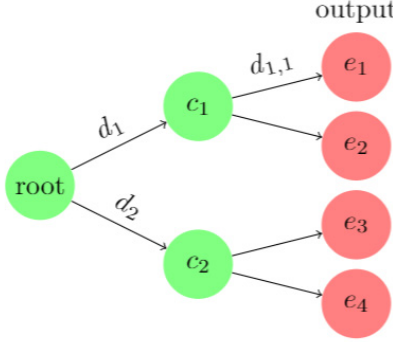
Figure 3. Example of a decision tree model.